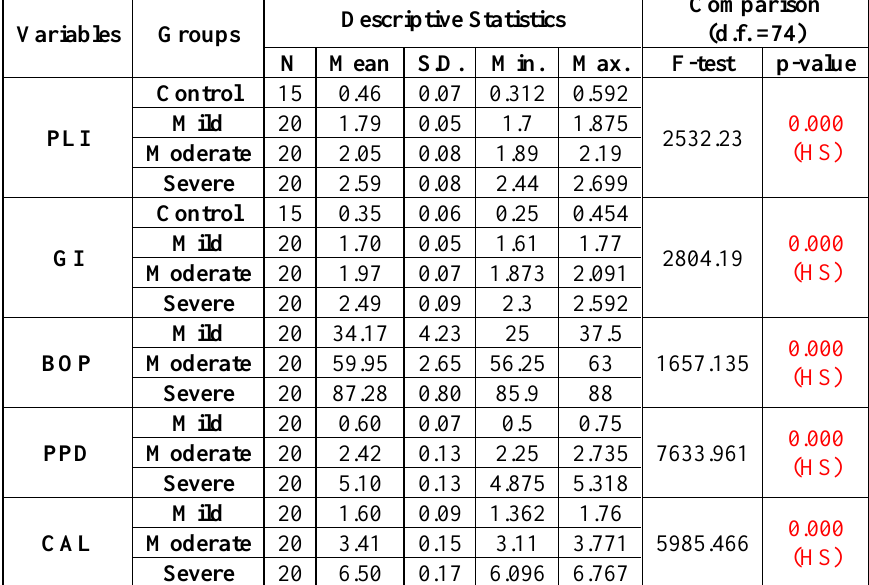
Table 1: Descriptive and inferential statistics of PLI, GI, BOP, PPD and CAL parameter for allstudy groups